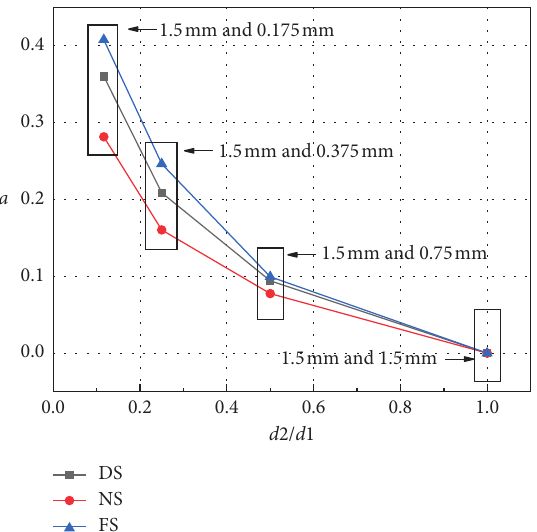
Figure 16: Curves of a and d